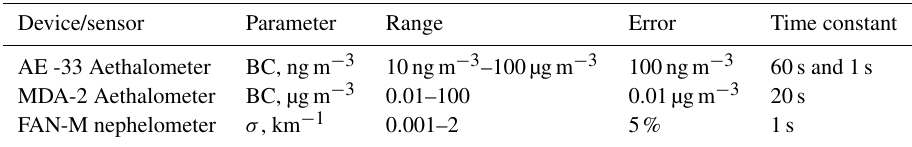
Table 3. Technical characteristics of the Aethalometer and